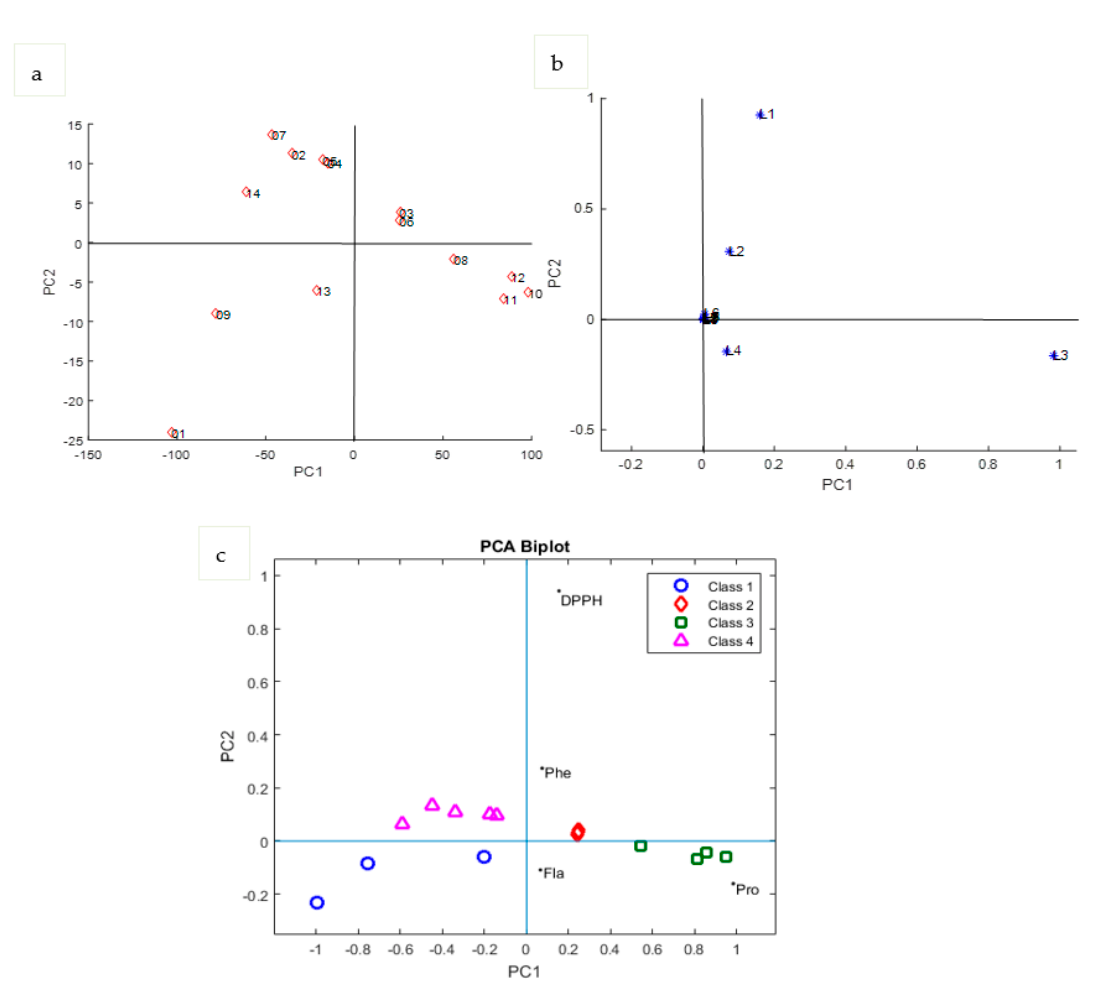
Figure 2. Principal component analysis showing: ( a ) score plot of the fourteen date pit cultivars; ( b ) loading plot of the 9 variables; ( c ) biplot of overlaid scores and loadings.